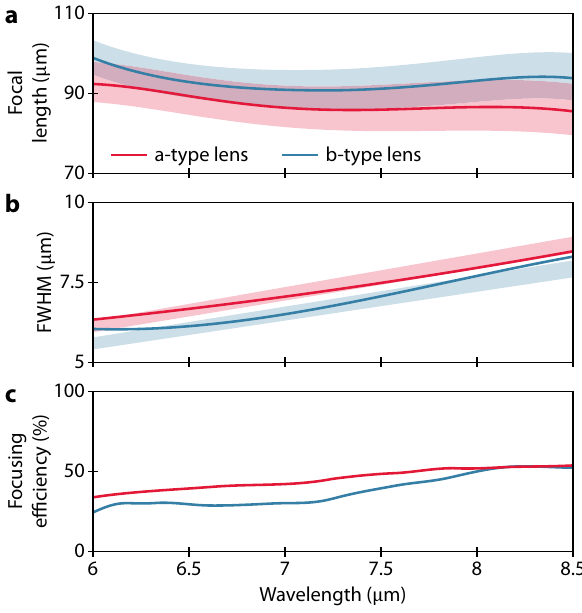
Figure4: Figuresofmeritofthemetalensesinthewavelengthrange λ = 6 – 8.5 μ m. (a) Focal length as a function of wavelength. Shadings indicate the depthoffield(DoF) – herede fi nedastheregioninwhichtheintensity ishigherthan95%ofthe value at thefocal point. (b) Full widthathalf maximum (FWHM) of the point spread function at the focal spots, where shadings indicate the diffraction limit ranges that correspond totheobservedfocallengthvariationsin(a).(c)Focusingef fi